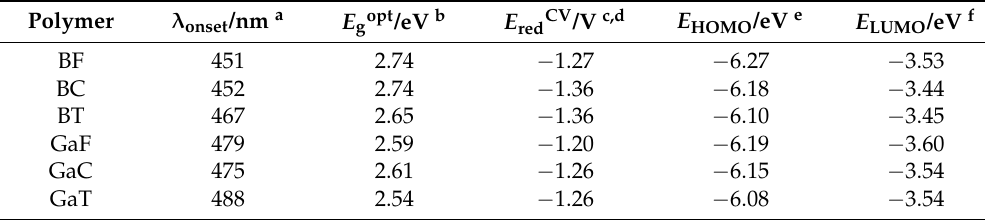
Table 3. Results of the absorption spectroscopy and the cyclic voltammetry.